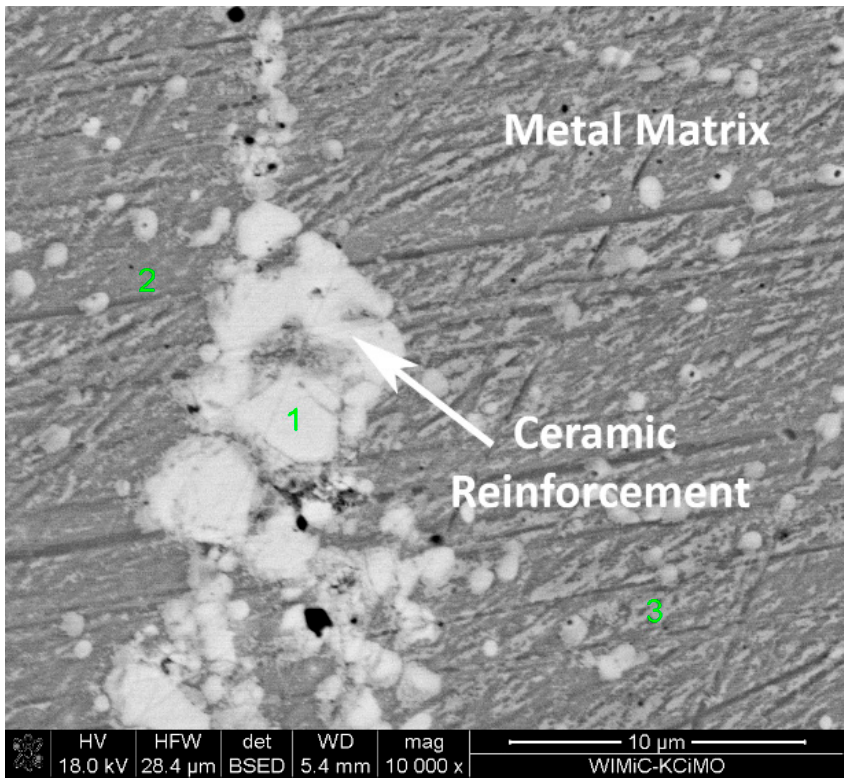
Figure 7. Example of interaction between ceramic reinforcement and metal matrix in obtained Inconel 625-5%NbC MMC materials.